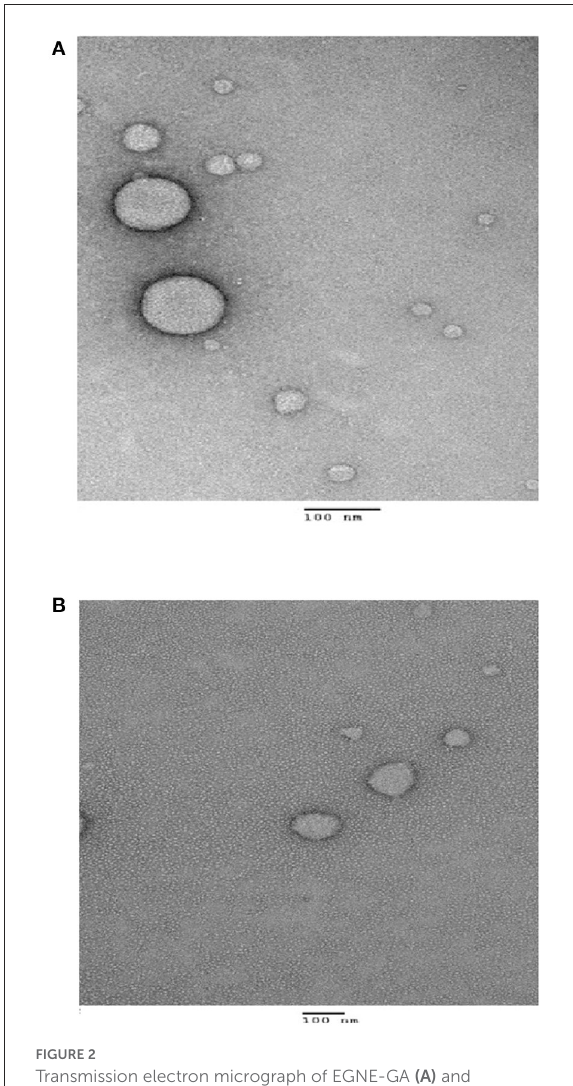
FIGURE2 Transmission electron micrograph of EGNE-GA (A) and EGNE-TW (B) .